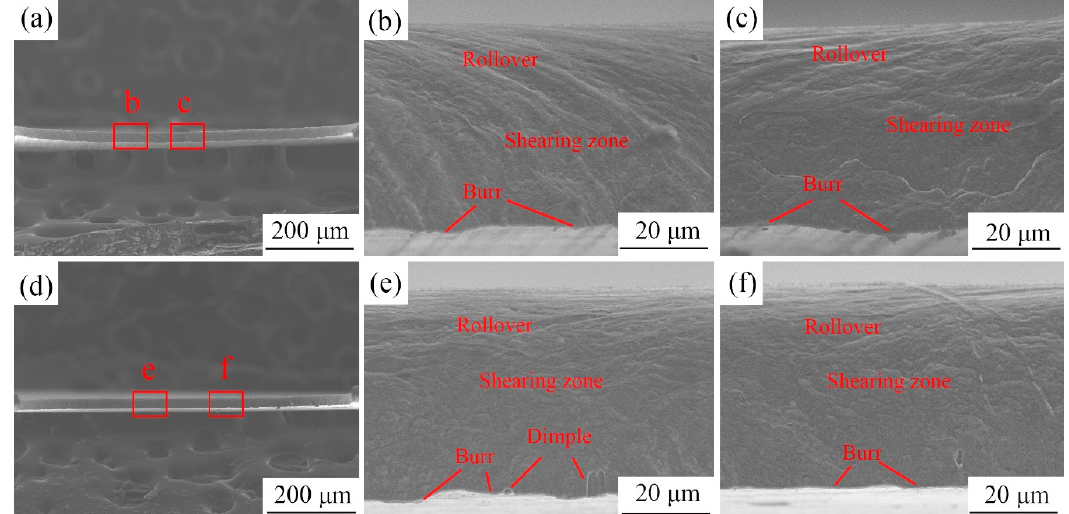
Figure 8. Comparison of the fracture surface of punched parts under a laser energy density of 38.2 J/cm 2 . ( a ) The punched part without LPS; ( b ) and ( c ) respectively correspond to the regions “b”, “c” in ( a ); ( d ) the punched part with LPS; ( e ) and ( f ) respectively correspond to the regions “e”, “f” in ( d ).